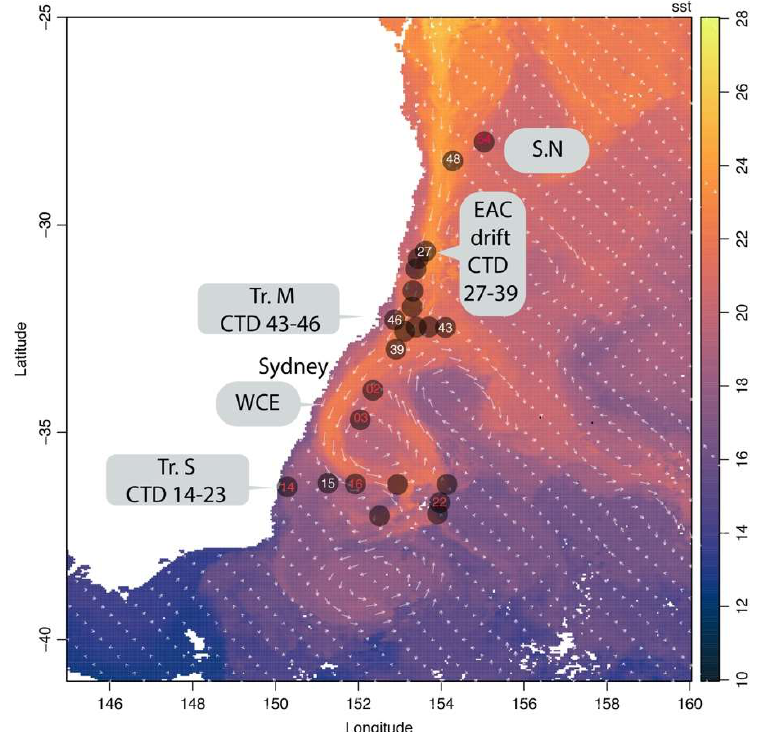
Figure 1. Location of the sampling sites along the east coast of Australia: Transect South (Tr.S), Transect middle (Tr.M), the Lagrangian drift along the EAC (EAC drift), the northern samples (SN) and the samples collected inside a warm core eddy (WCE). Data for the 8-day composite average surface seawater temperature on a 4 km resolution were obtained from the Australian Ocean Data Network portal (https: // portal.aodn.org.au / ) for the period September 2016. Sampling sites and transects are highlighted. Colours of the CTD deployments are related to the availability of metagenomes for either the microbial fraction (white) ( > 0.2 µ m) or the microbial ( > 0.2 µ m) and viral fraction ( < 0.2 µ m) (red).